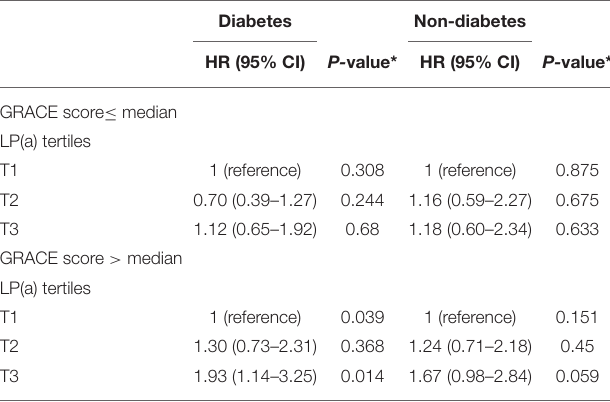
TABLE 3 | Risk of cardiovascular events according to lipoprotein(a) and GRACE score in patients with or without diabetes. Diabetes